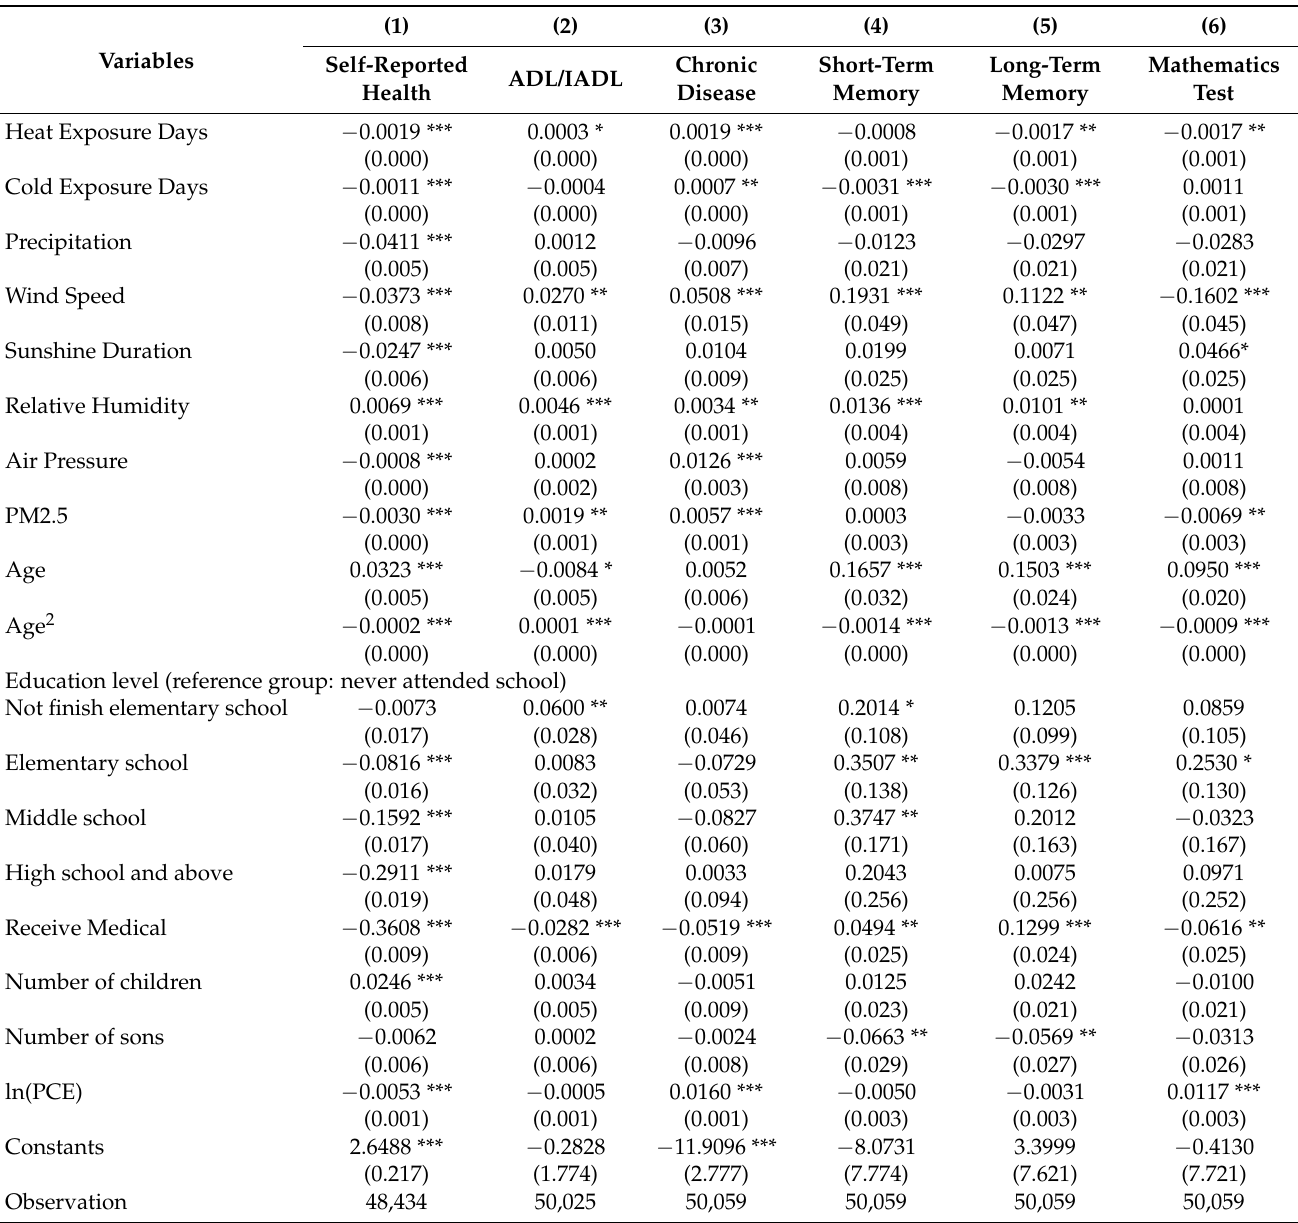
Table 2. Results of the basic